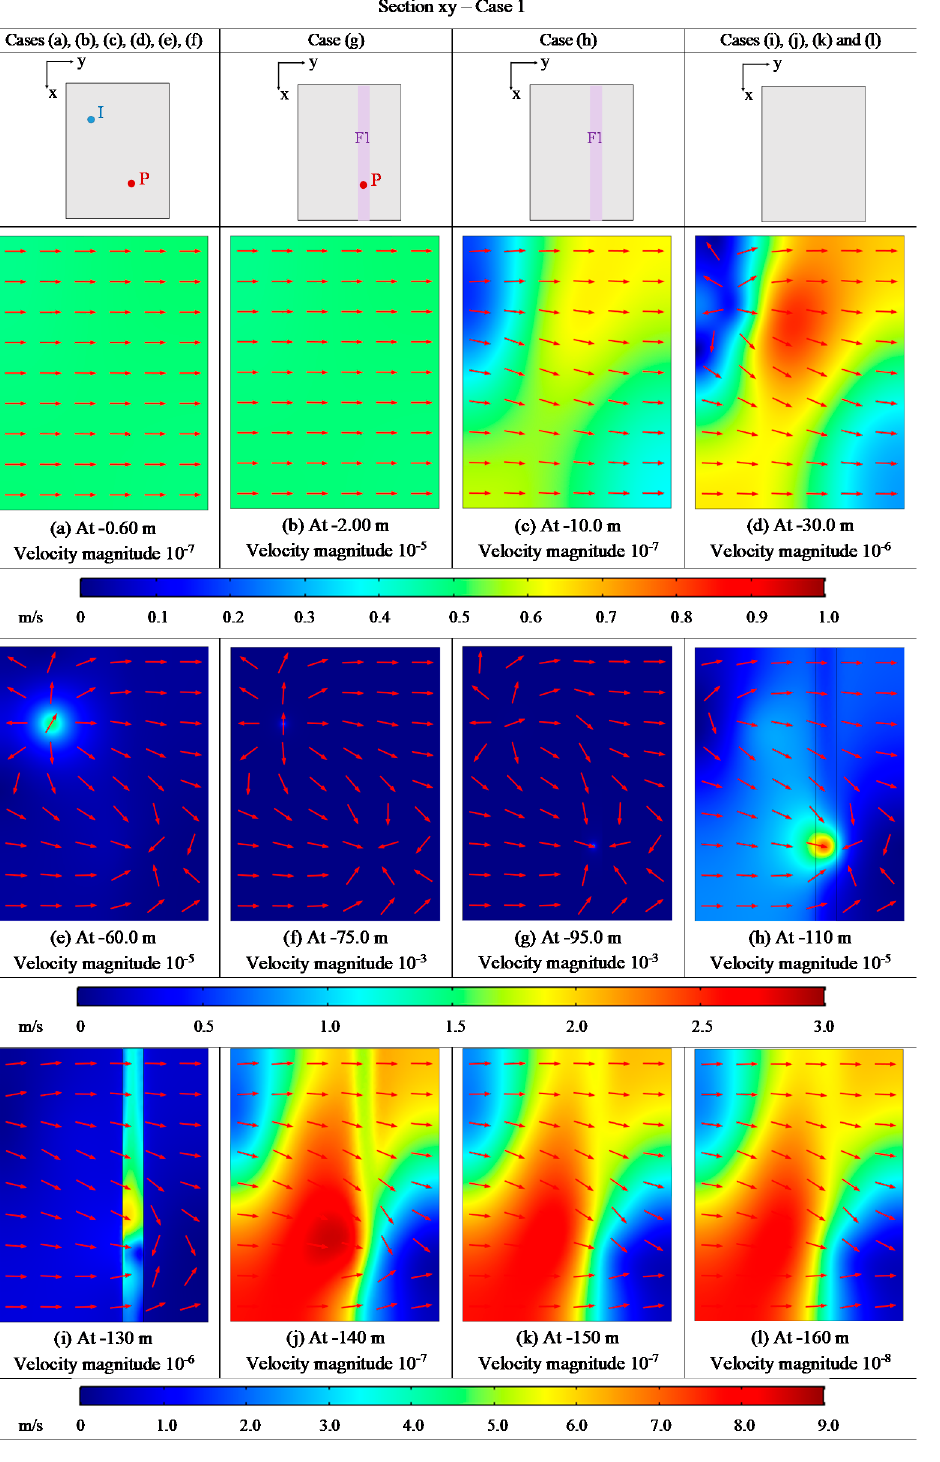
Figure 13. Darcy velocity field at different depths for Case 1 (single fault).